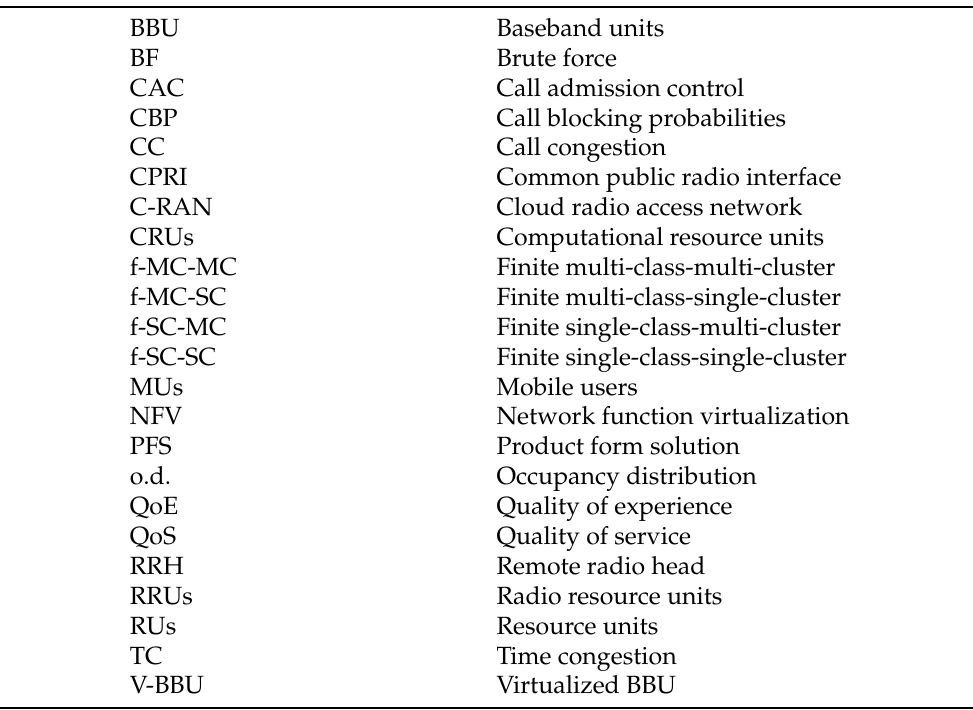
Table 1. Abbreviations